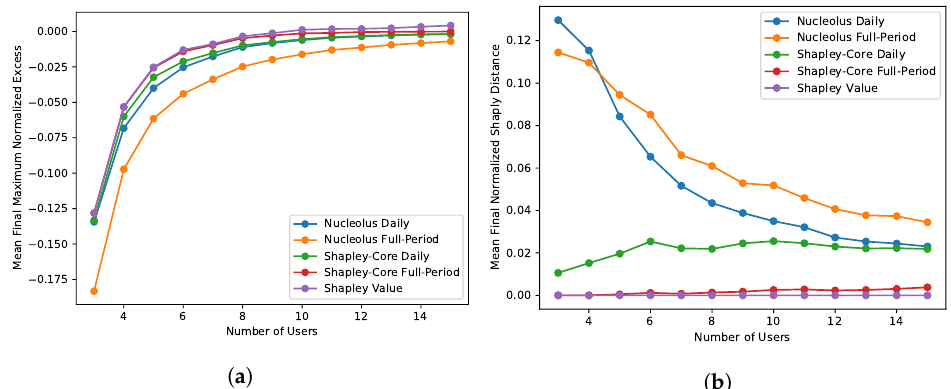
Figure 15. Mean final normalized excess ( a ) and normalized Shapley distance ( b ) with different benefit distribution schemes in 1000 trials broken down by the number of users in the